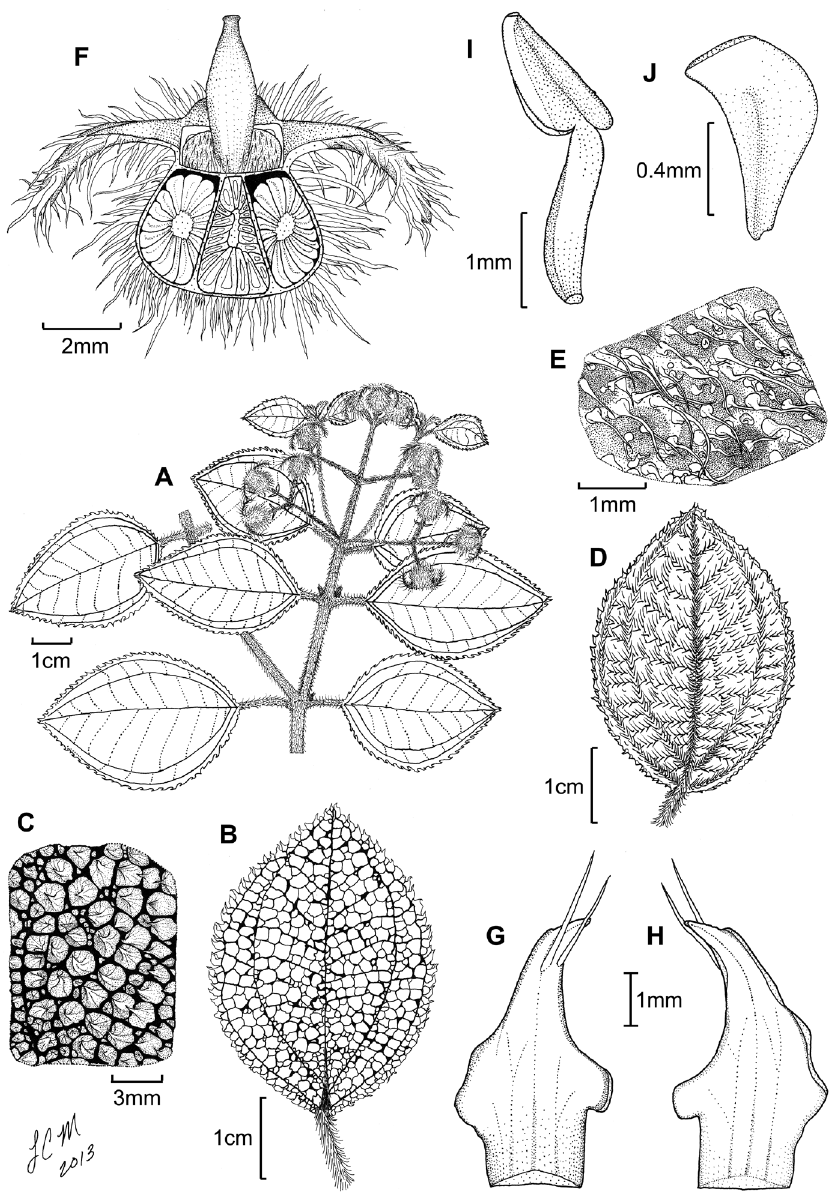
Figure 24. Illustration of Miconia phrynosomaderma. A habit of M. phrynosomaderma with the bulla- based hairs removed from the adaxial leaf surface to show venation B leaf adaxial surface C close-up of adaxial leaf surface showing expanded bulla-based hairs not fully covering the entire lamina D leaf abaxial surface E close-up of abaxial leaf surface showing sparse bulla-based hairs and clearly visible lamina F lon- gitudinal section (slightly oblique) of young fruit G petal abaxial surface H petal adaxial surface I stamen showing anther with short dorso-basal appendage J immature seed (all drawn from Ekman H8204 ). Re- produced with permission from Majure and Judd